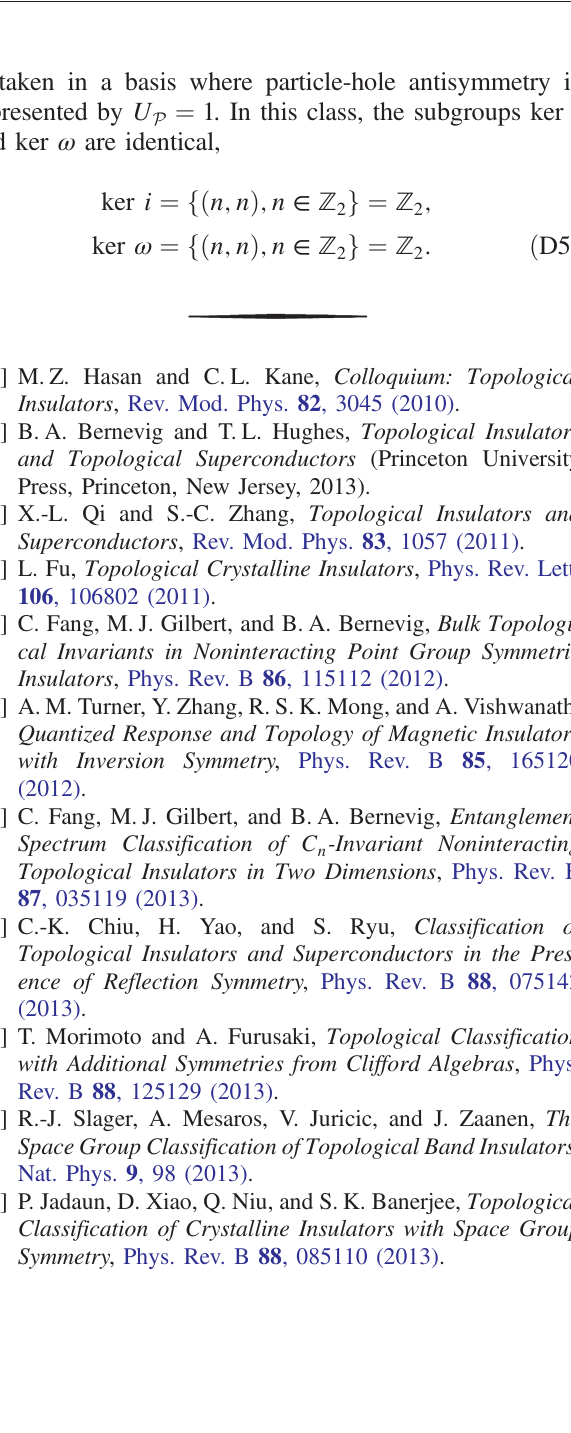
TABLE XXVI. The subgroups K